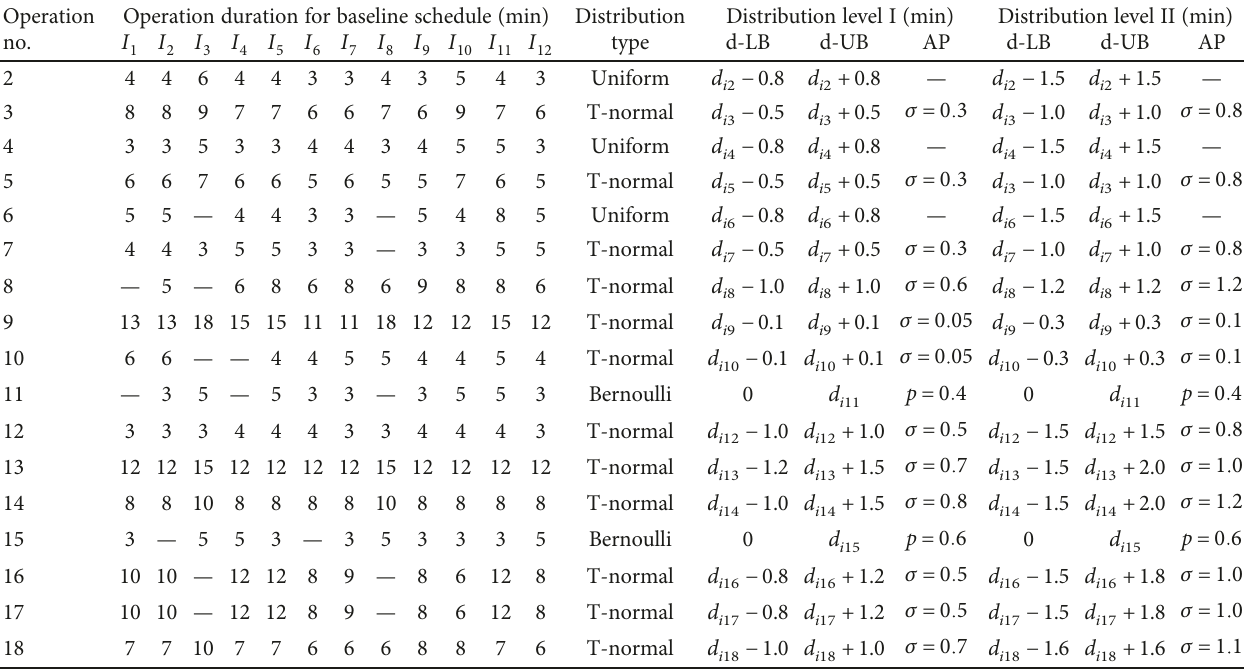
Table 7: Operation durations for a team of aircraft.